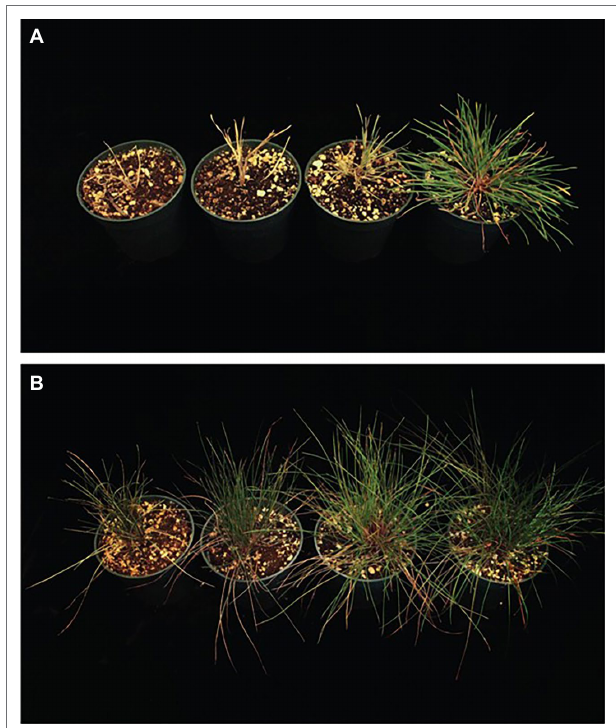
FIGURE 5 | (A) Summer dormancy response of sandberg bluegrass ( Poa secunda J. Presl.) accession PI 232348 to various photothermal combinations representative of Ames, IA, United States. (B) Non-summer dormant red fescue ( Festuca rubra L.), cv. “Audubon” under identical photothermal conditions. Summer dormant PGCs could reduce competition with cash-row crops (e.g., maize) during the growing